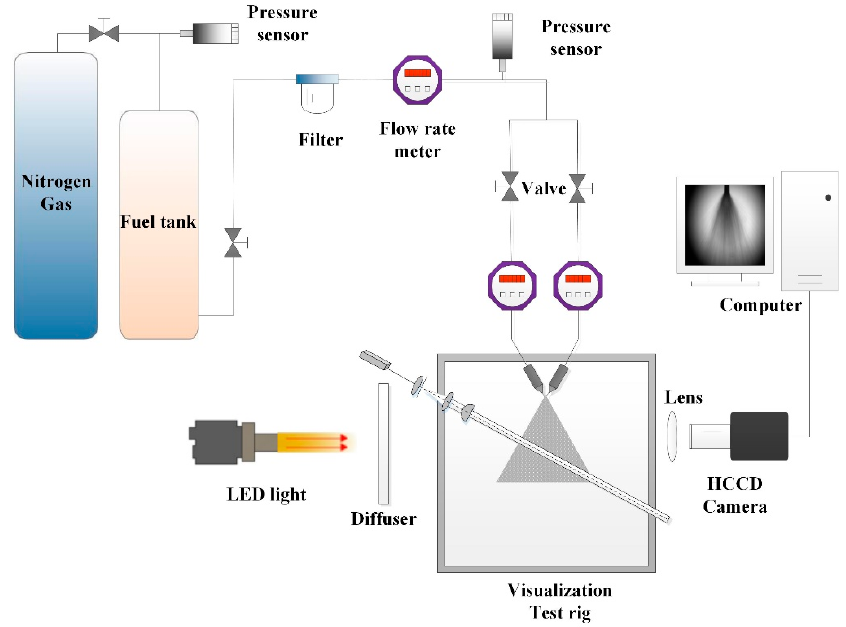
Figure 4. Schematic diagram of the impact nozzle experimental system [21].